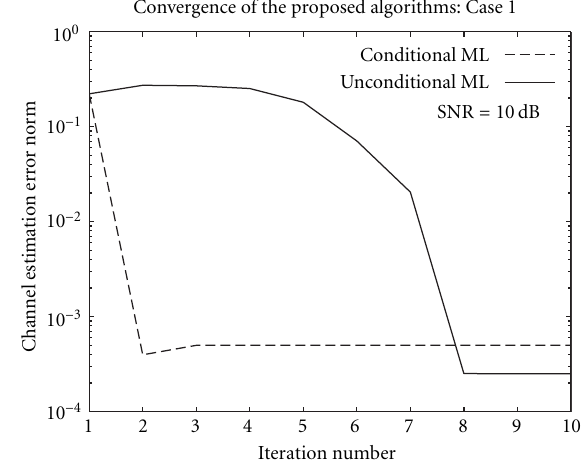
Figure 4: Case 1: Channel matrix estimation error norm.